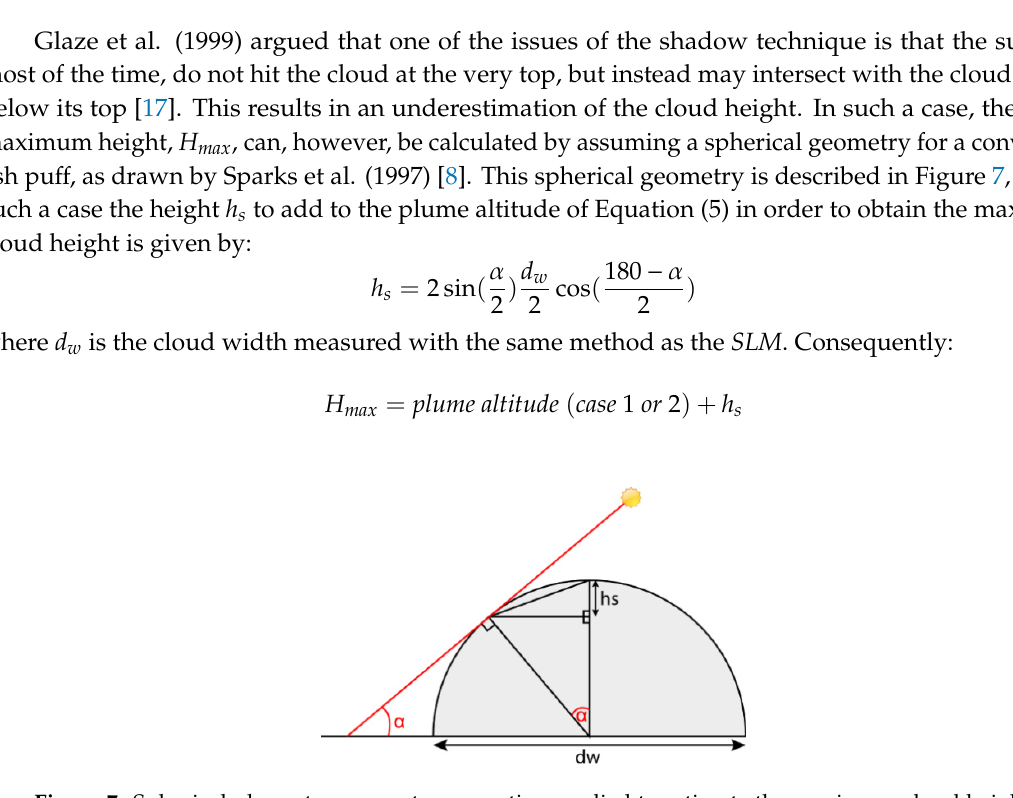
Figure 6. ( a ) Comparison of cloud and shadow projections between raw and post-processed (geometrically corrected, level 1) data. ( b ) Geometry for the resolution of the ortho-rectification issue in two dimensions.